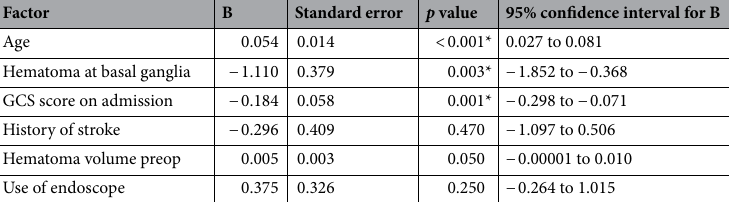
Table 4. Shift analysis using ordinal logistic regression analysis for factors associated with mRS score at 6 months. Ordinal logistic regression analysis was performed using, in addition to the use of the endoscope, the factors selected by univariate analysis with p < 0.10 and |r|> 0.20; Age, hematoma at basal ganglia, GCS score, history of stroke, and preoperative hematoma volume. B, coefficient; GCS, Glasgow Coma Scale; mRS, modified Rankin Scale. * p < 0.05 by ordinal logistic regression